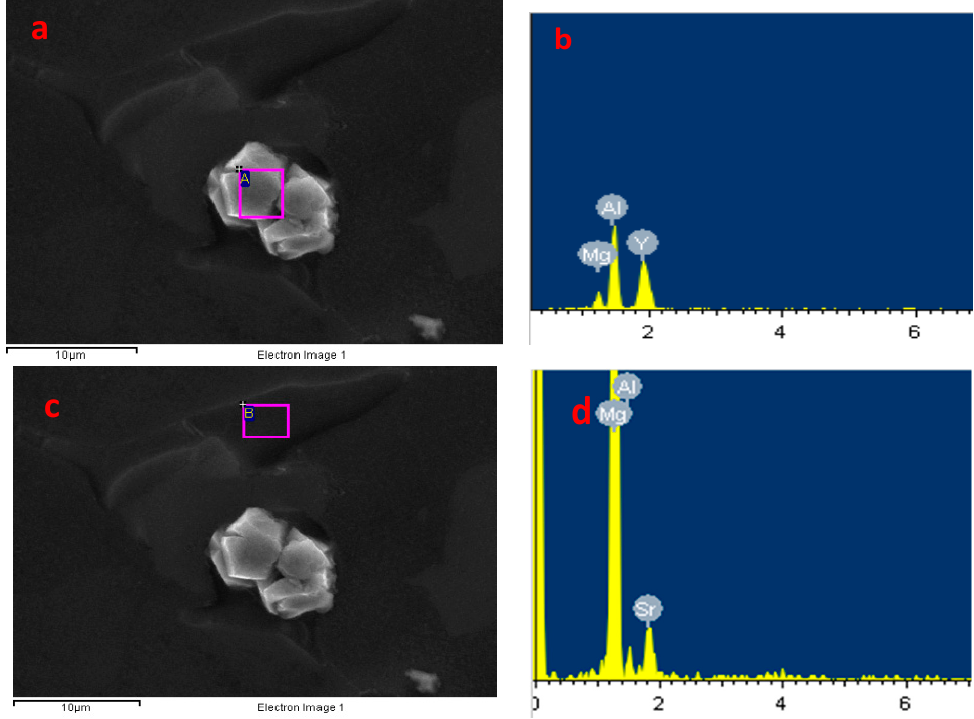
Figure 3. The SEM and Energy Dispersive Spectroscopy (EDS) results of Al 2 Y ( a , b ) and Al 4 Sr ( c , d ).